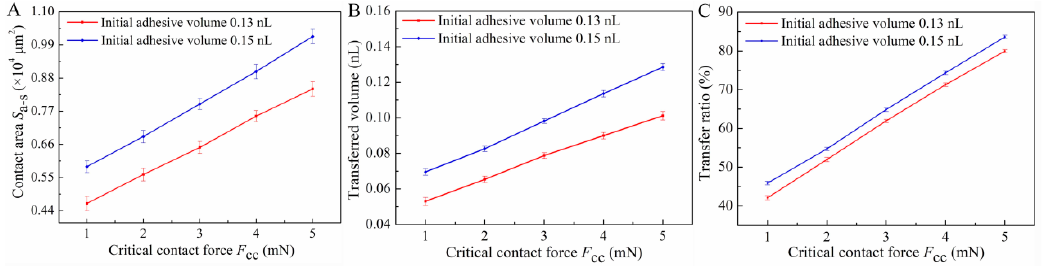
Figure 9. Variation of ( A ) contact areas S a-s , ( B ) transferred volume, and ( C ) transfer ratio with increase of F CC .